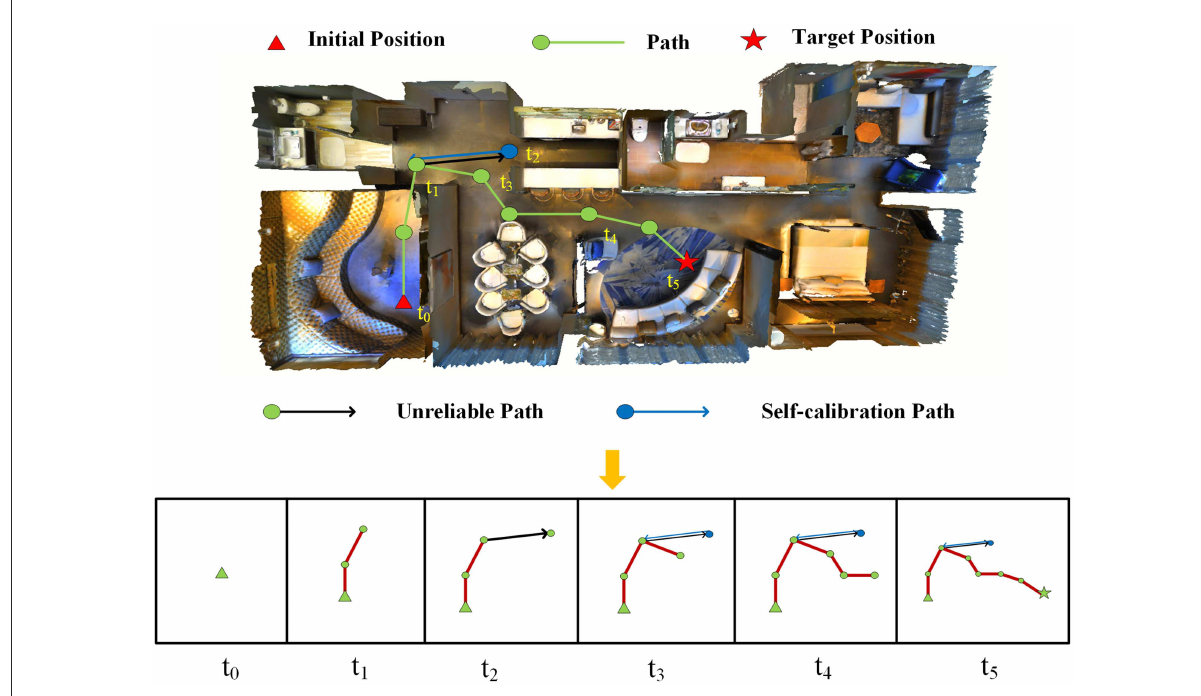
FIGURE4 Examples of navigation trajectory. The path is rasterized and written into the memory image.